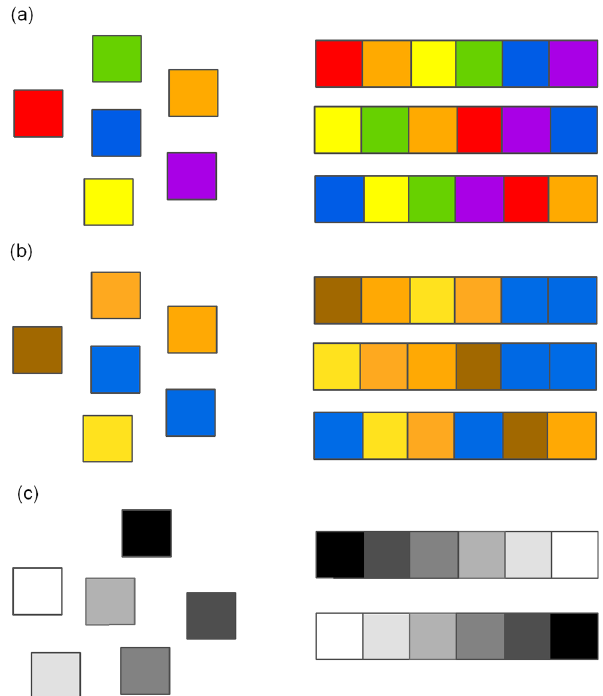
Fig. 3. (a) A demonstration that six colours of different hue have no natural order and are unsuitable for continuous data; (b) a Deutera- nope colour blind simulation of the colours shown in (a) , this shows orange and green and blue and purple look almost identical to colour blind people; (c) a greyscale sequence is easily ordered and there- fore very suitable for sequential data. Adapted from Borland and Taylor, 2007.